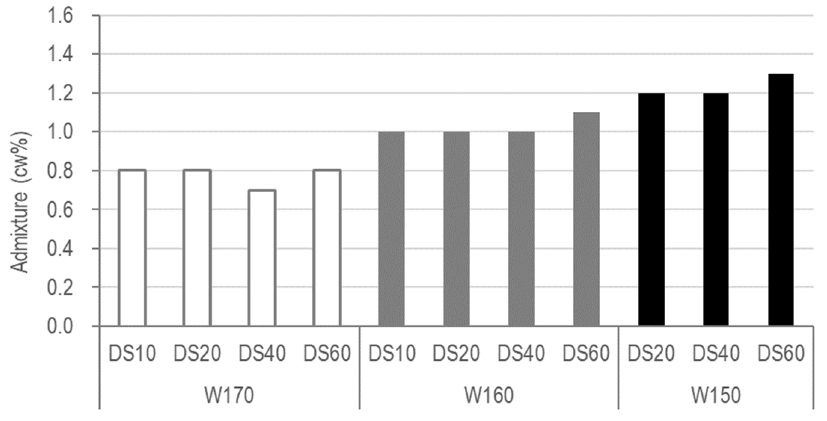
Figure 3. Admixture (AD) contents of the concrete mixtures used to attain the target slump.